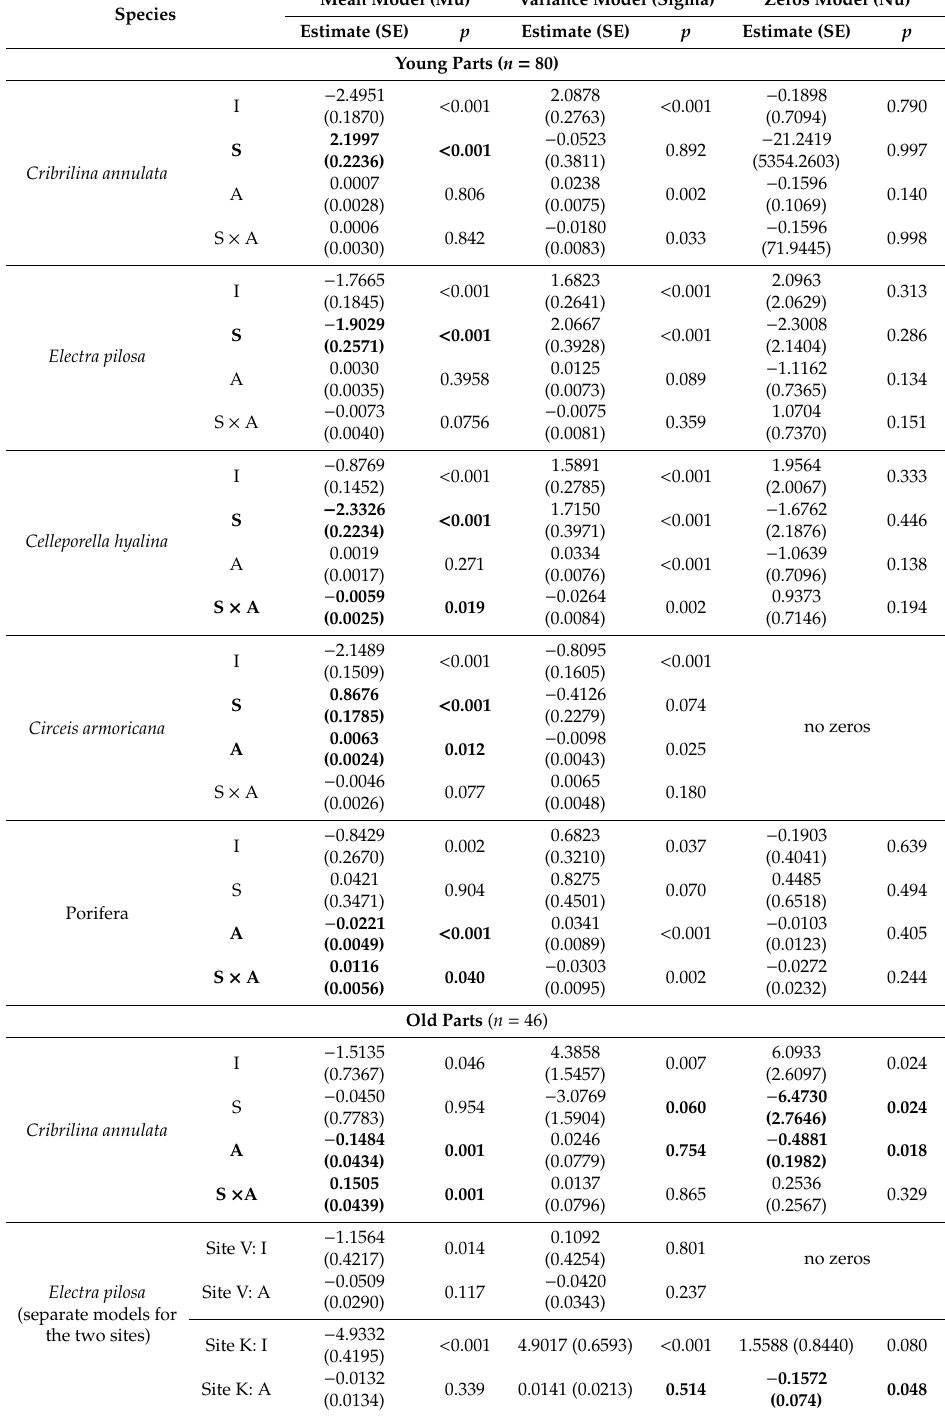
Table 8. E ff ects of plant part size (surface Area of the corresponding part, cm 2 ) and location (Sites K or V) on relative abundances of 5 top abundant species on young and old plant parts of Phycodrys rubens in September 2015: zero-inflated (logit link) beta-regression, mean (logit link) and variance (log link) modeled, frames pooled. I—intercept, Sources of variation: S—Site (K), A—plant part surface area. The model did not converge for E. pilosa on old blades since all the zero observations were at Site K, thus two separate models for the two sites were fitted. Significant terms in mean and zero models highlighted in